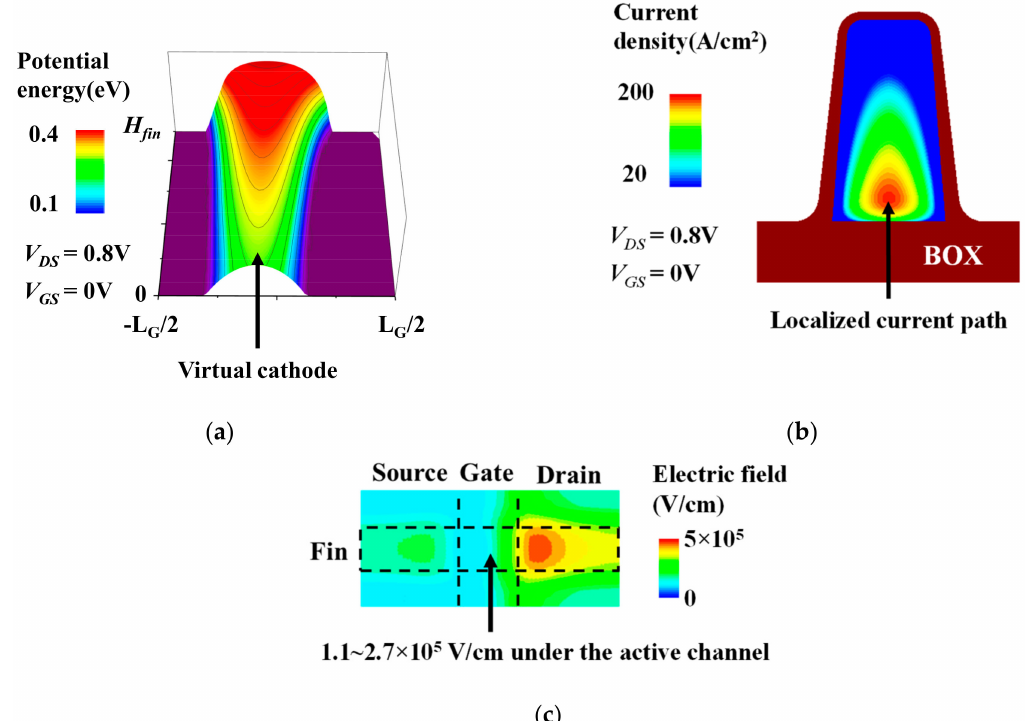
Figure 6. Simulation results of the 14 nm node SOI n-FinFET without TID hardening. ( a ) The potential energy distribution in channel region, ( b ) the sub-threshold current distribution in the tapered fin and ( c ) the distribution of the electric field in the BOX perpendicular to the channel/BOX interface.